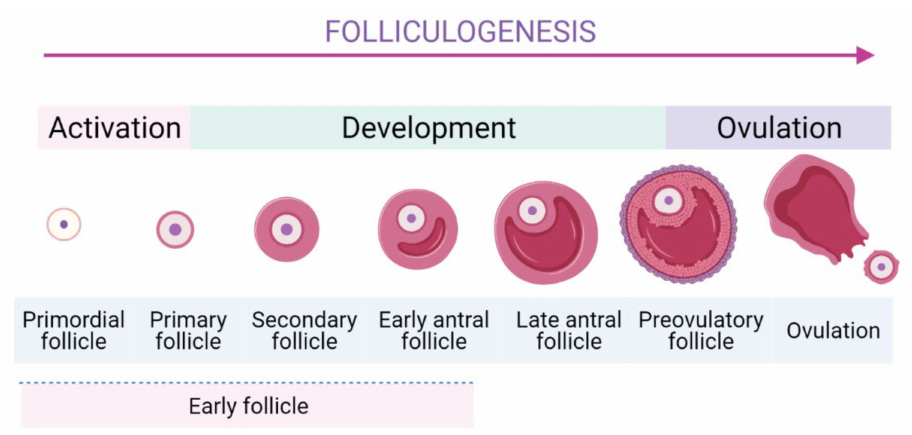
Figure 1. The schematic folliculogenesis from primordial to ovulatory